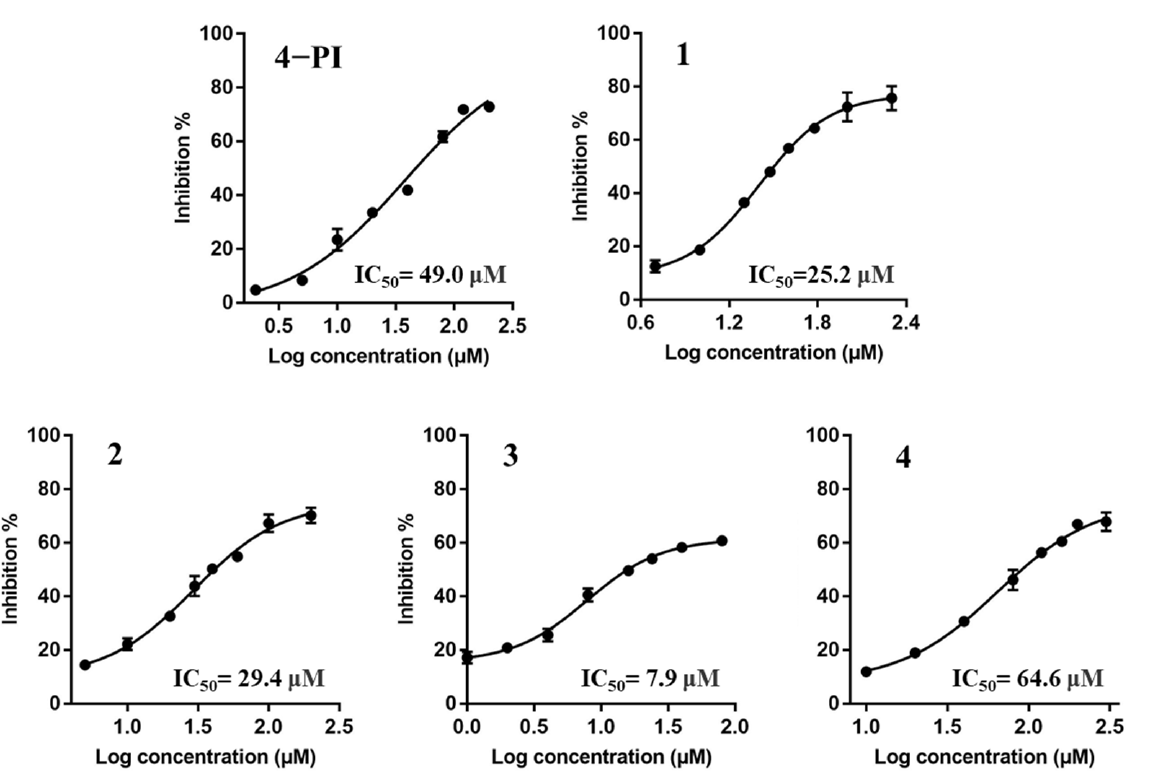
Figure 5. Four inhibitors are tested through IDO1 inhibitory activity assays with 4 − PI as a positive control. The IC 50 values are presented as the mean ± SD with three independent determinations.